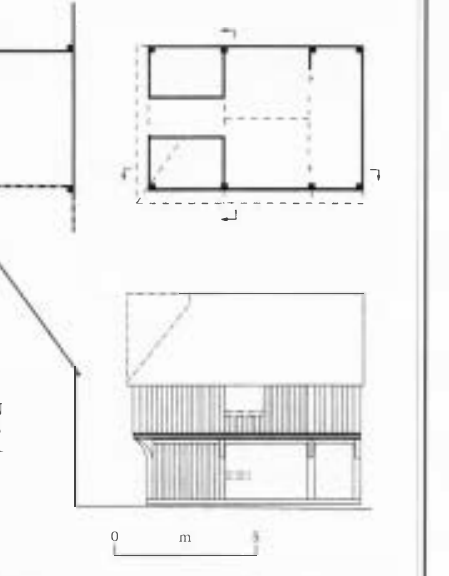
J Figure 3 The detached kitchen at Com­ phurst (Wartling, Sussex) showing its superficial house-like appearance. Note the relationship of the building to the main house on the west (left) side, and the